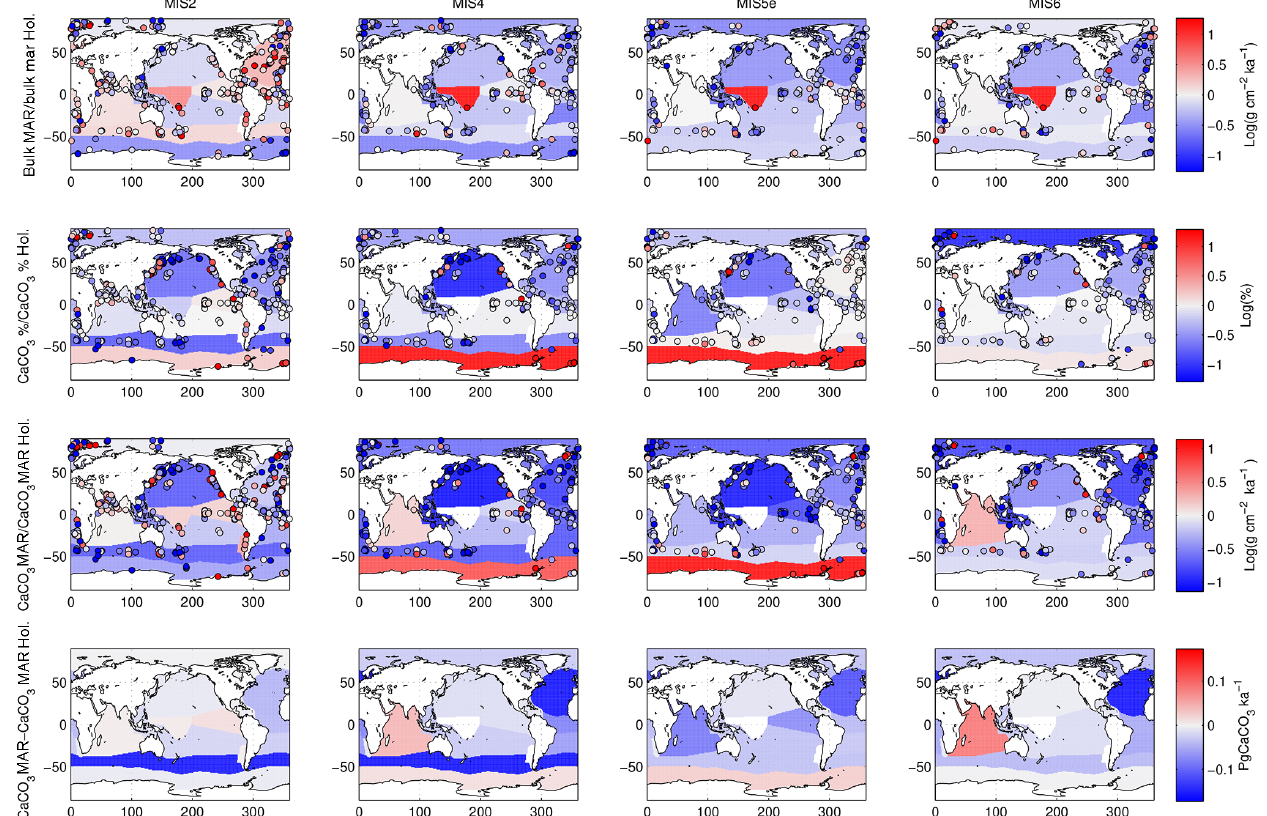
Figure 4. Example of calculated changes in deep-sea sedimentation relative to the Holocene using one province map. The first three rows show relative changes in bulk sediment MAR, carbonate content, and carbonate MAR, while the last row shows absolute changes in carbonate MAR. Changes are shown for the LGM and Marine Isotope Stages 4, 5e, and 6. Note that the absolute carbonate flux refers to the integrated burial over the province (not area normalized). The modern map used here corresponds to Fig. 2a, and the province map is S.L.2. Note that the data shown here are not corrected for the long-term trend of accumulation rate, as the correction is calculated and applied at the global burial